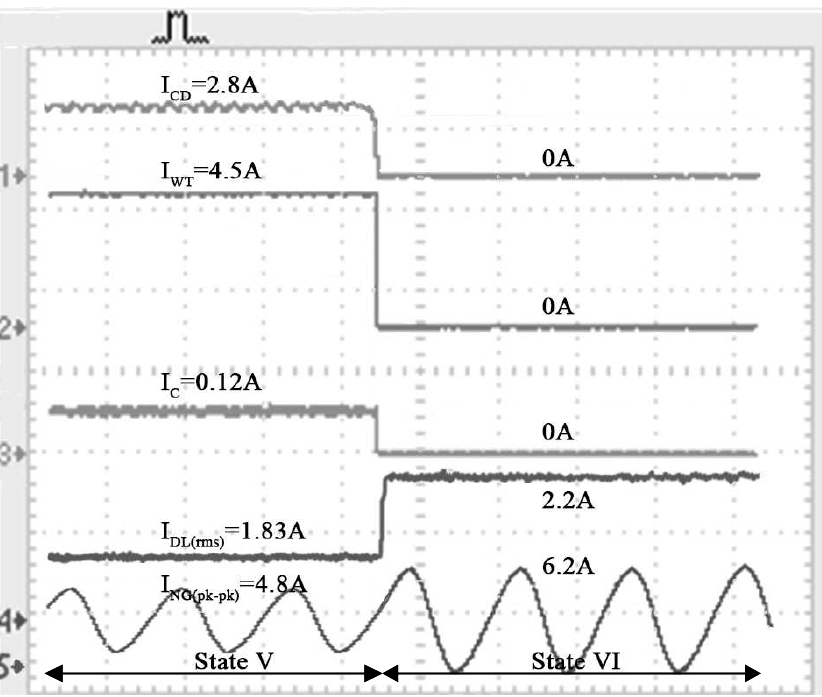
Figure 31. Experimental result for states V and